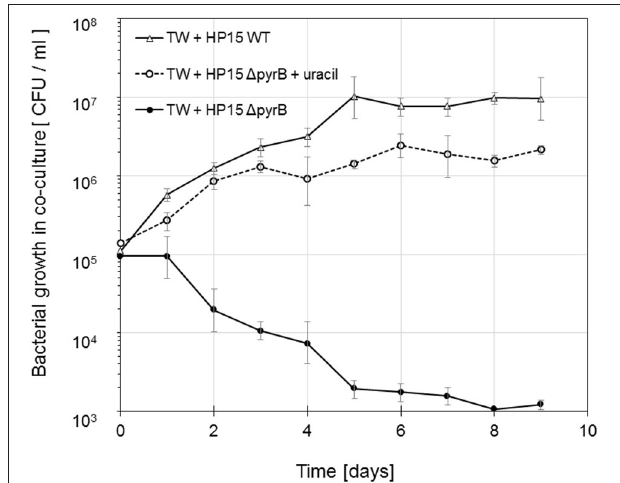
FIGURE 2 | Growth of M. adhaerens HP15 1 pyrB in co-culture with T. weissflogii in F/2 media with and without uracil (5 µ g ml − 1 ). M. adhaerens HP15 wild-type was used as a positive control. Experiment was conducted with three biological replicates, error bars represent standard deviation.